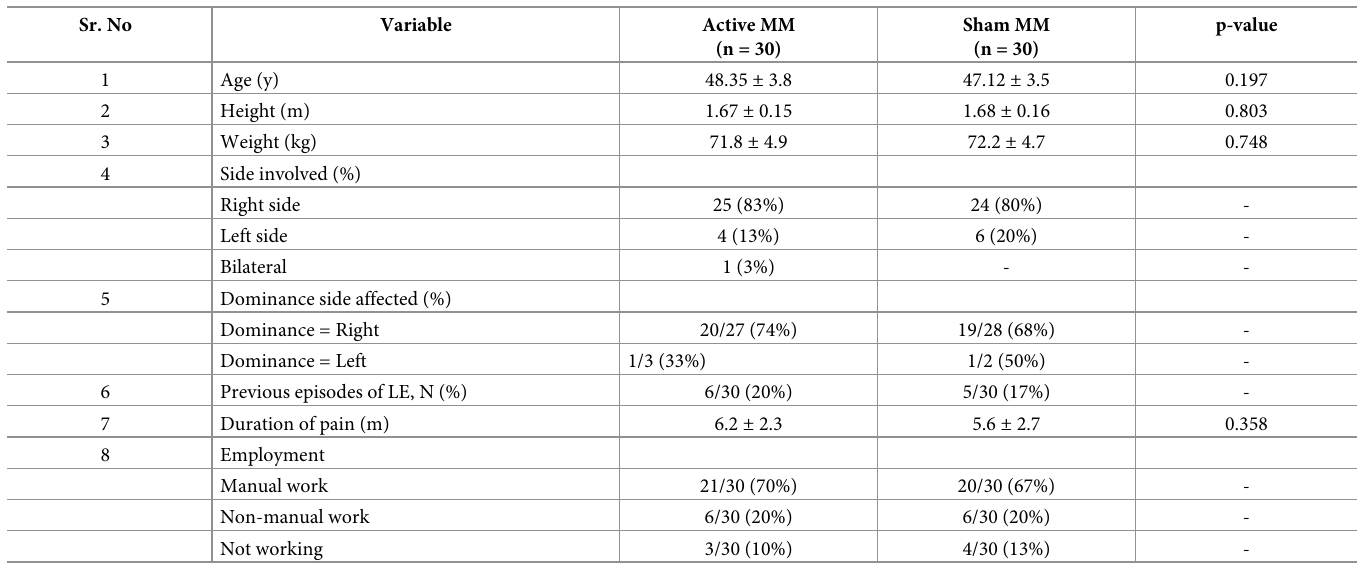
Table 1. Demographic and clinical characters of active and sham MM